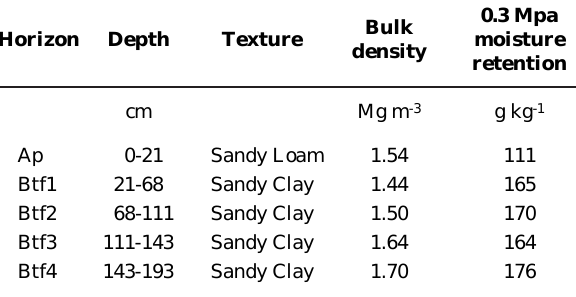
(1) Based on Souto Maior